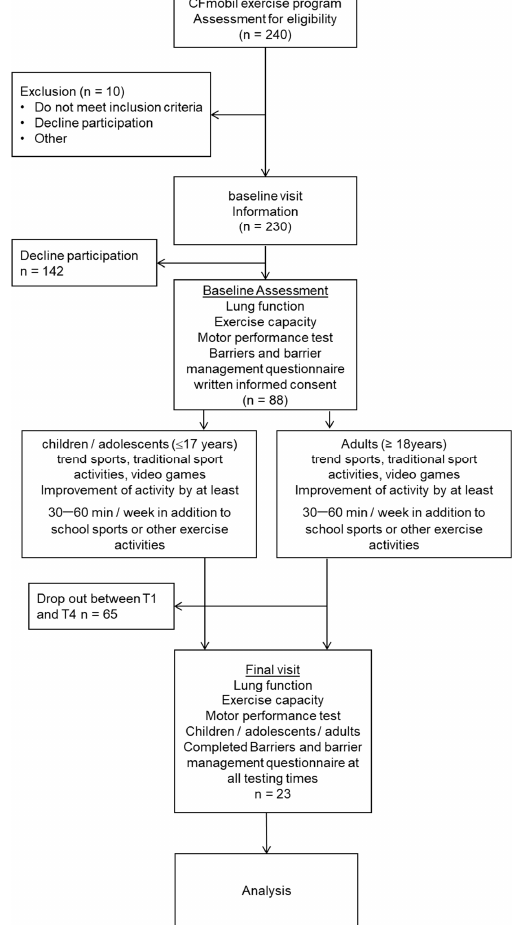
Figure 1. Selection flowchart of participants.